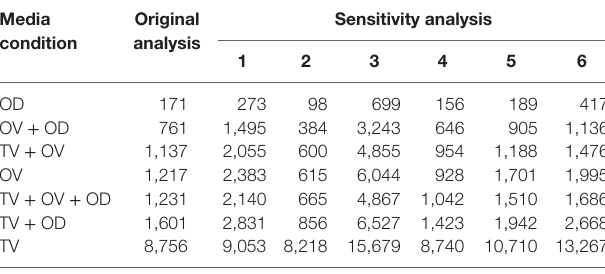
taBlE 5 | Cost-effectiveness of each media condition: original analysis and sensitivity analyses. Media